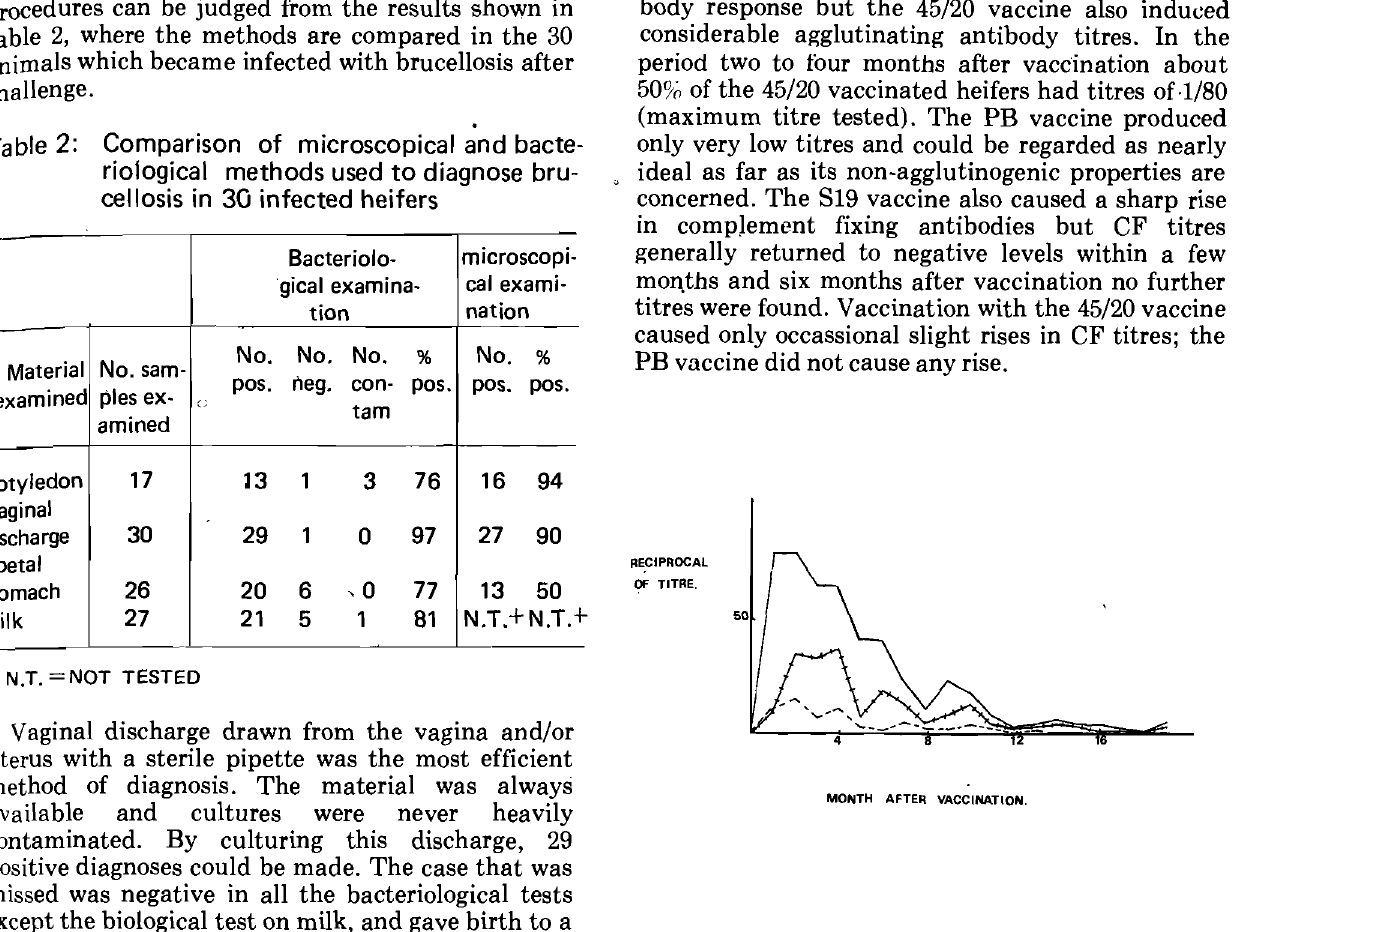
Geometric means of the serum agglutinatin antibody titres in heifers vaccinated with - - 819; - - - - - - PB; and ++++++ 45/20 adjuvant